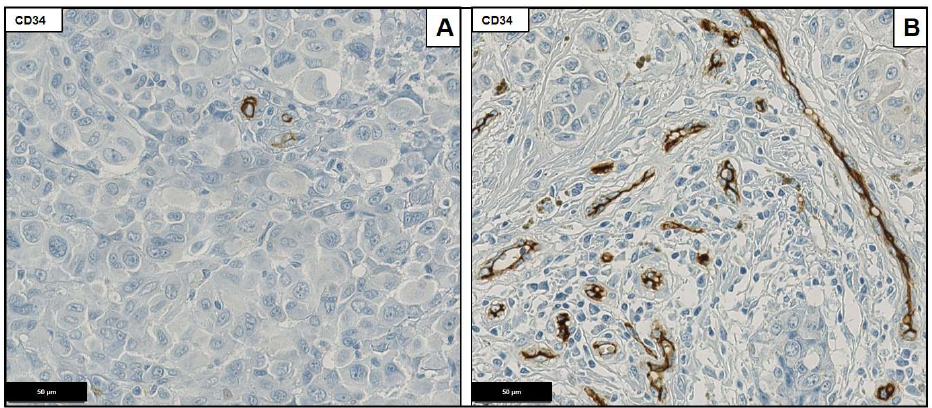
Figure 3. CD 34 staining demonstrating low (<20; A ) and high (≥20; B ) capillary density. Magnifica- tion ×40.